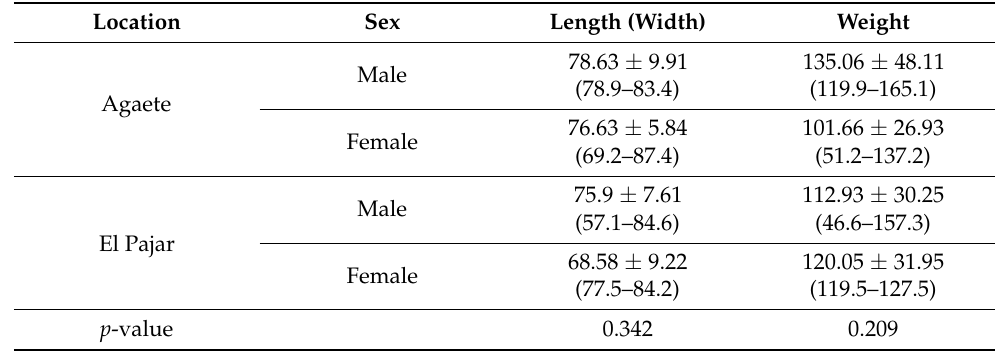
Table 1. Biometric data (sex, length, and weight) of Cronius ruber in the study locations.